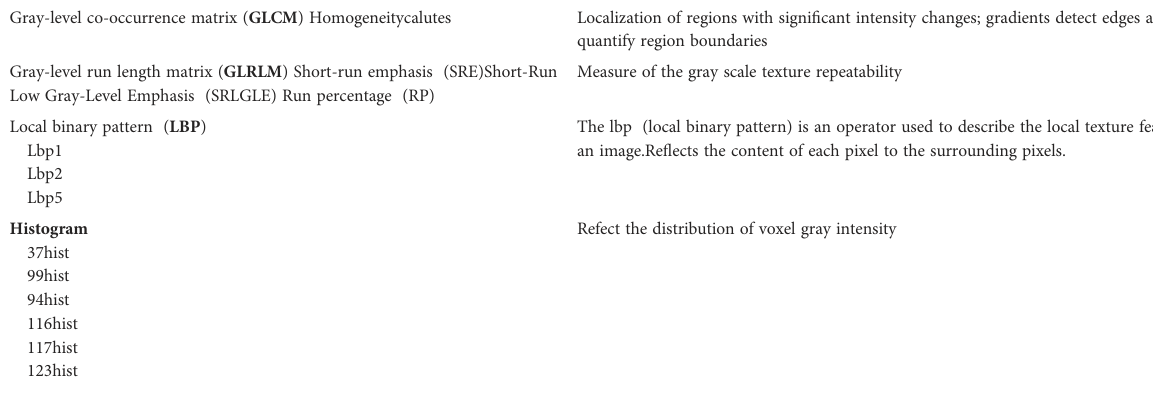
TABLE 2 Selected features with descriptions.